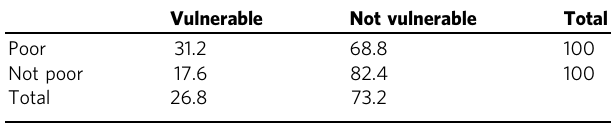
Pearson chi-squared (1) = 259.5036, Pr =